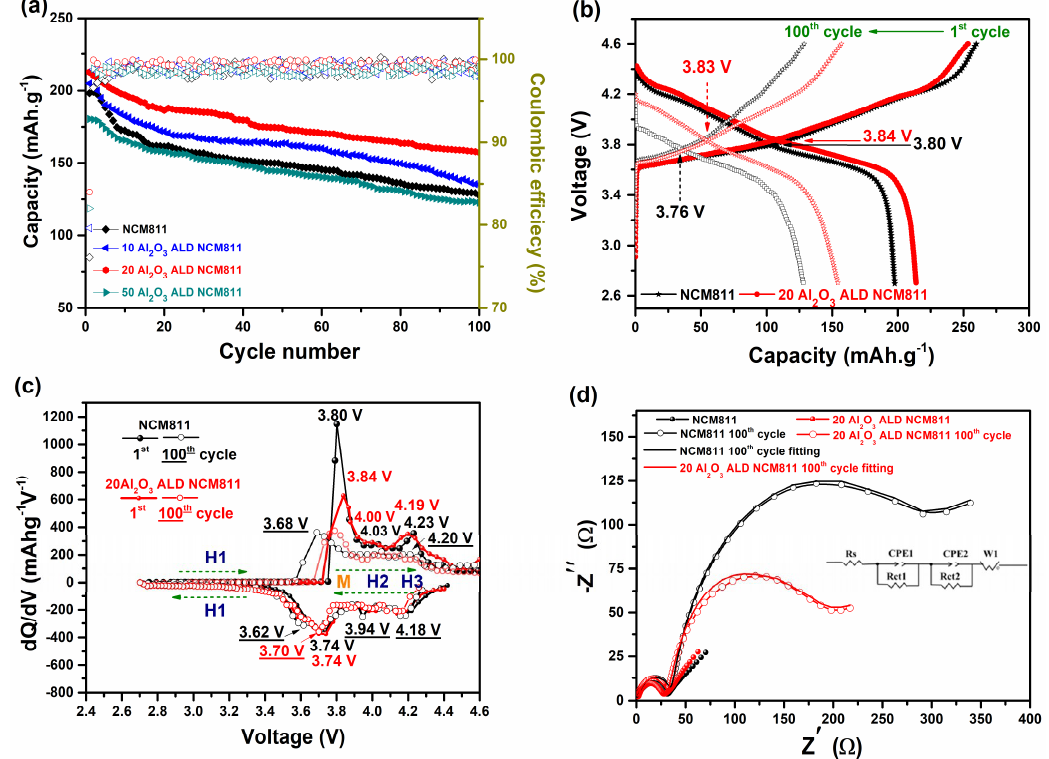
Figure 4 Electrochemical performance of different cathode materials in a broad voltage range of 2.7– 4.6 V vs. Li + /Li: ( a ) cycling performance at 0.1 C for 100 cycles; ( b ) charge/discharge curves of